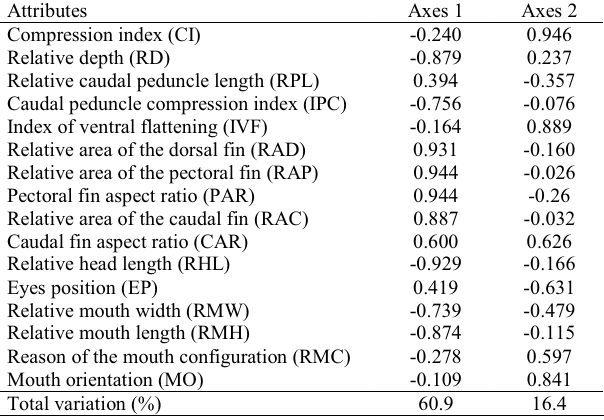
Fig. 11. Dendrogram of the ecomorphological relationships for the 15 studied fish species. Table 5. The correlation index values between each ecomor- phological attribute and the correspondent axes, and the vari- ance attracted for the two principal axes of